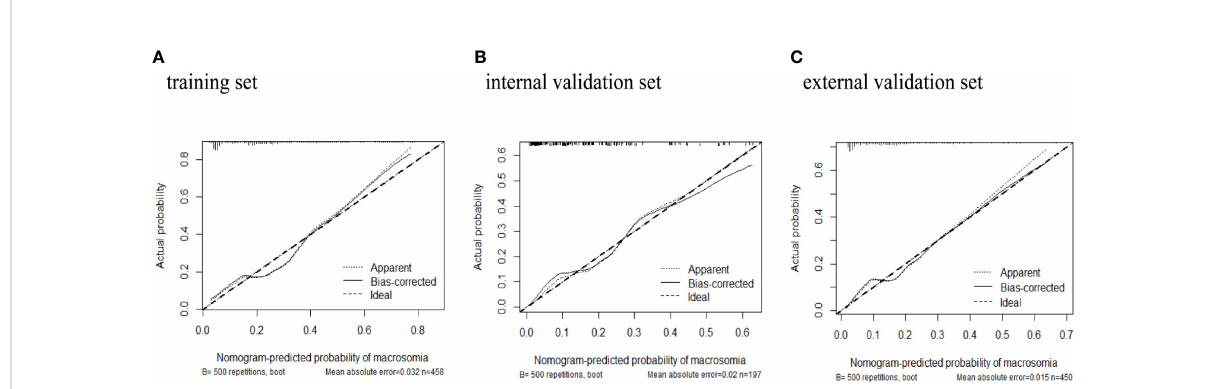
FIGURE 5 Calibrationplotsof macrosomia risknomogramprediction. Thex-axis representsthepredictedriskof macrosomia. They-axisrepresentstheactual diagnosed caseof macrosomia. Thediagonaldottedline representsaperfectpredictionby anideal model. Thesolidline representsthe performance of the (A) trainingset, (B) internal validationset, (C) external validationset. Thecloser fi tofsolidline tothe diagonal dotted linerepresentsabetterprediction.